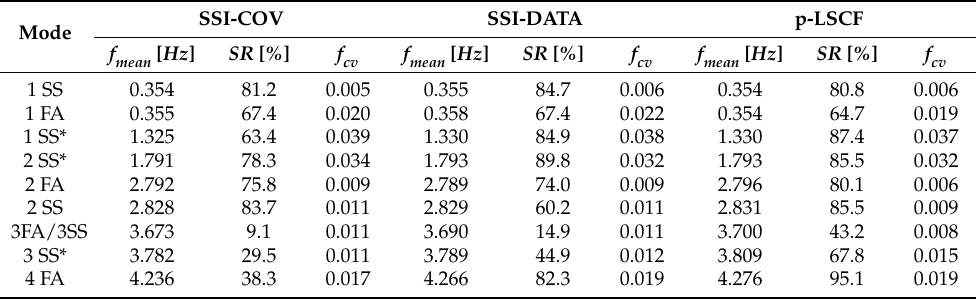
Table 1. Statistics related to the results obtained with the three modal identification